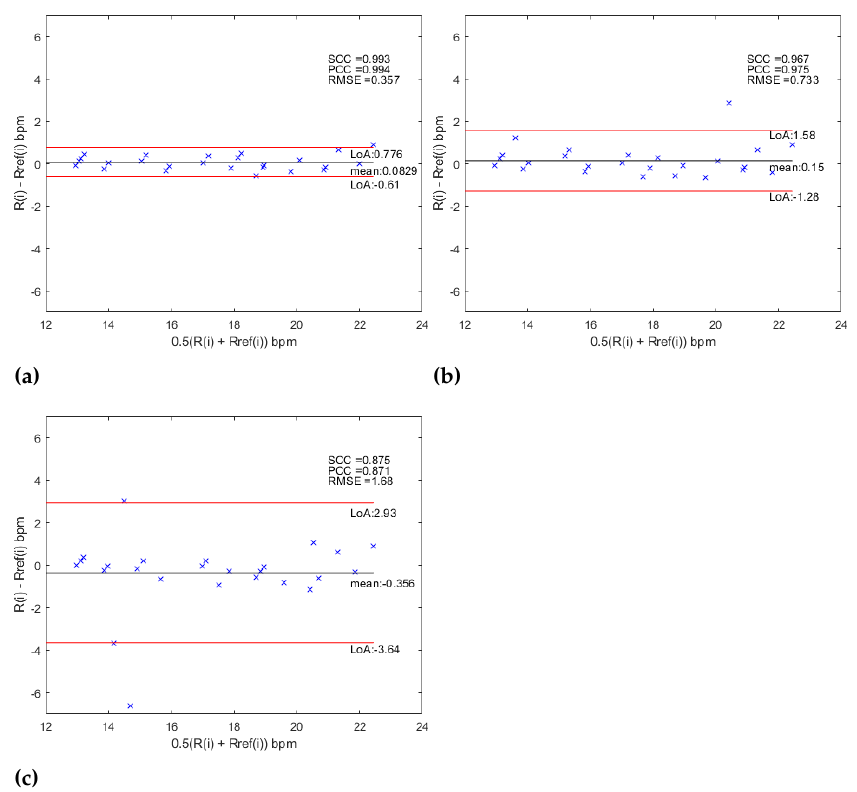
Figure 10. Bland–Altman analysis for ( a ) CNN-MCV, ( b ) CNN-MV and ( c ) CNN-OV.